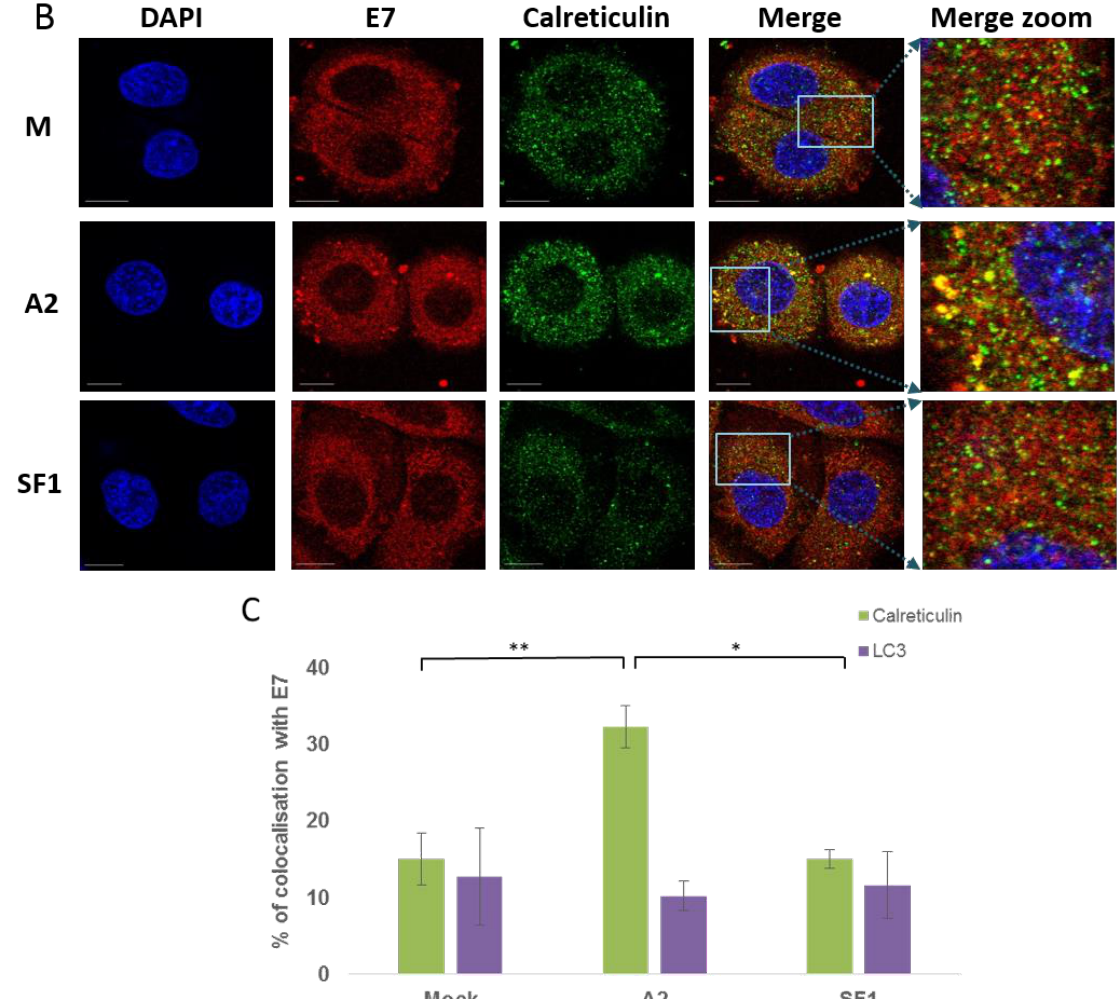
Figure 6. E7 does not co-localise with an autophagosome marker, LC3 ( A ) but appears to co-localise with endoplasmic reticulum marker calreticulin ( B ) in the presence of A2. SiHa cells were mock-transfected (M) or transfected with 100 nM A2 or SF1 using Oligofectamine. At 14 h post-transfection, cells were co-stained with anti-E7 (Abcam) and either anti-LC3 (an autophagosomal marker) or anti-calreticulin (an ER marker) prior to incubation with either AlexaFluor568 rabbit anti-mouse or AlexaFluor488 goat anti-rabbit secondary antibodies. Red, Green and Blue are E7, FITC (LC3, autophagosome) and DAPI (nucleus), respectively. The last panel is a zoom of merged images. The scale bar = 10 µm. E7/LC3 and E7/calreticulin colocalisation was analysed using Bitplane:Imeris image analysis software based on the calculation of Pearson’s correlation coefficient values and presented as percentage co-localisation ( C ). n = 21, 23 and 17 for E7/LC3 and n = 19, 39 and 20 for E7/calreticulin with mock-, A2- and SFI-treatment, respectively. * p ≤ 0.0005, ** p ≤